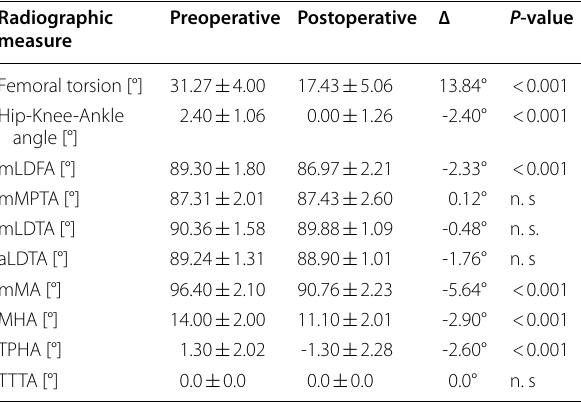
measures in patients